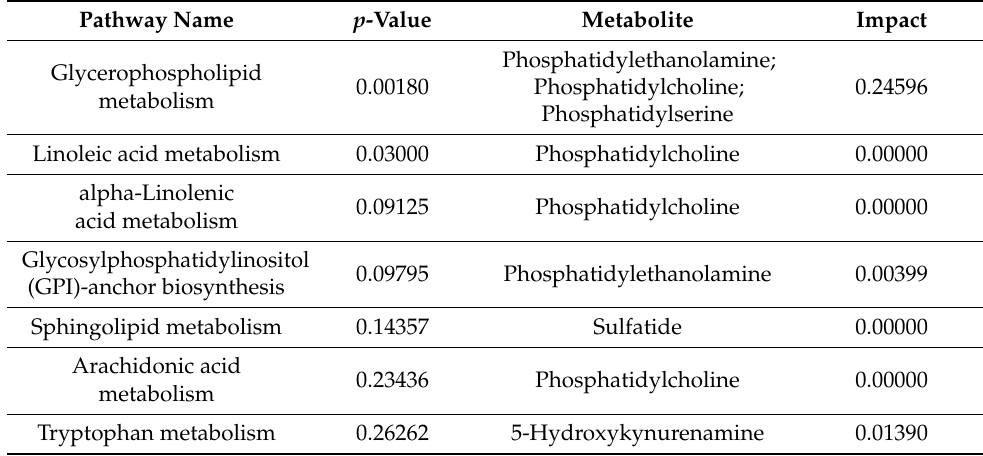
Table 2. The enriched KEGG pathway of differential metabolites of Cela/tMCAO in mouse plasma.